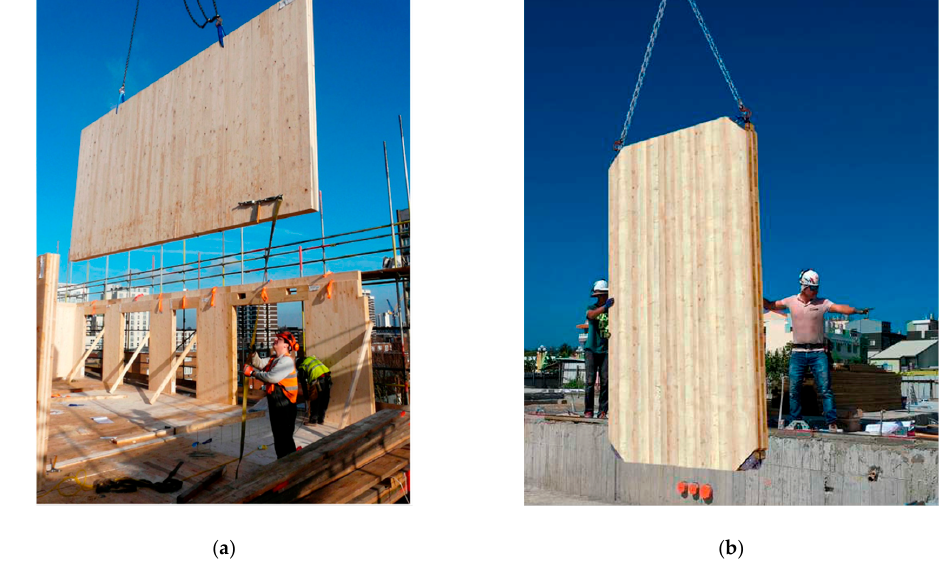
Figure 7. Panel lifting with ( a ) the conventional method [86] and ( b ) novel connectors (CLT-C2)